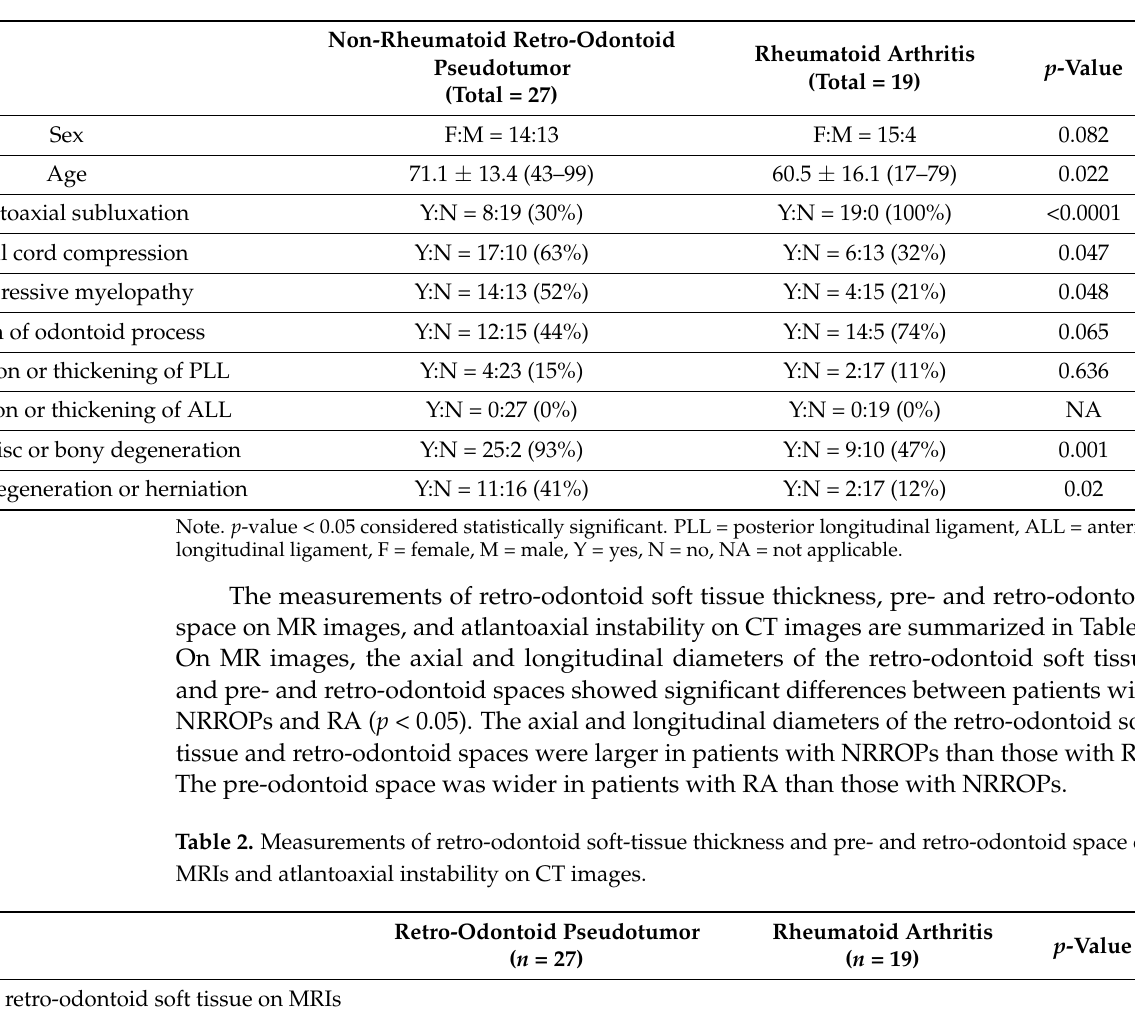
Table 1. Clinical data and imaging results of ROP patients and RA patients with atlantoaxial joint involvement.